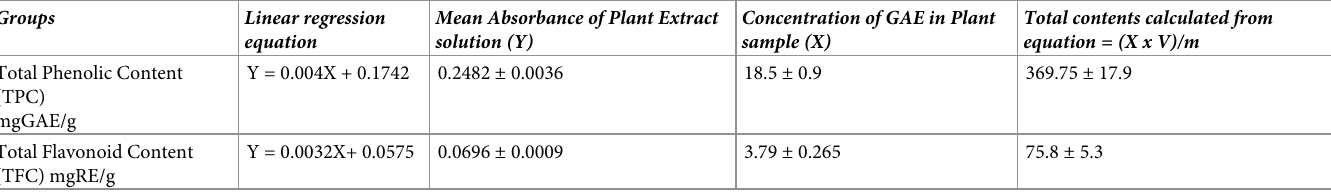
Table 1. Total phenolic contents (TPC) and total flavonoid contents (TFC) of Syzygium leaves extract. Groups Linear regression